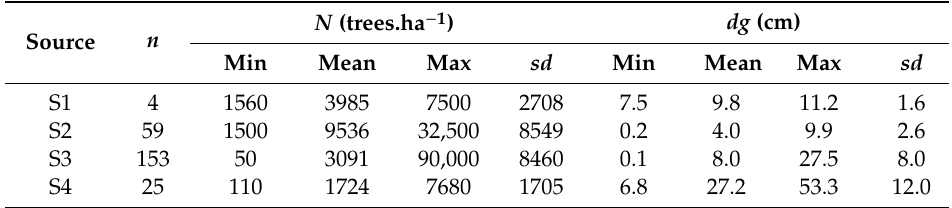
Table 1. Summary characteristics of the number of trees per hectare ( N ) and quadratic mean diameter ( dg ) for the sampled plots of maritime pine. N (trees.ha − 1 Source n